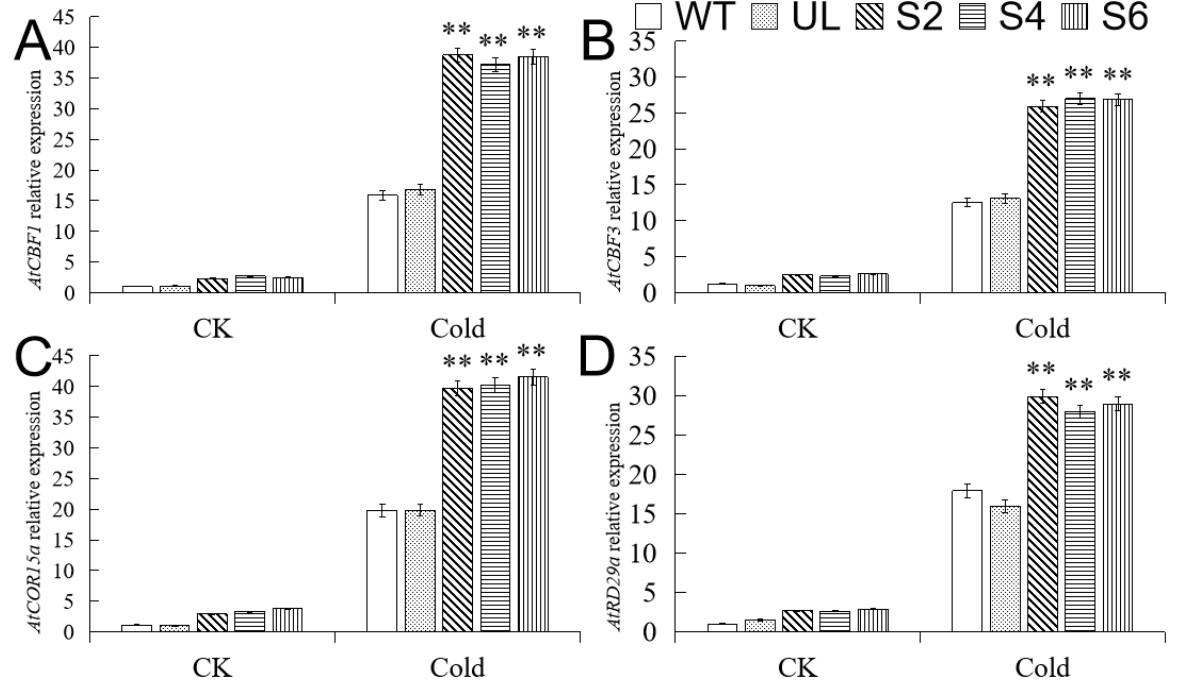
Figure 6. Relative expression levels of cold stress-related genes in WT, UL, and transgenic A. thaliana. Relative expression levels of AtCBF1 ( A ), AtCBF3 ( B ), AtCOR15a ( C ), and AtRD29a ( D ). Data represent the mean of three replicates. Error bars represent standard deviation. Asterisks above error bars indicate significant difference compared to the WT line (** p ≤ 0.01).